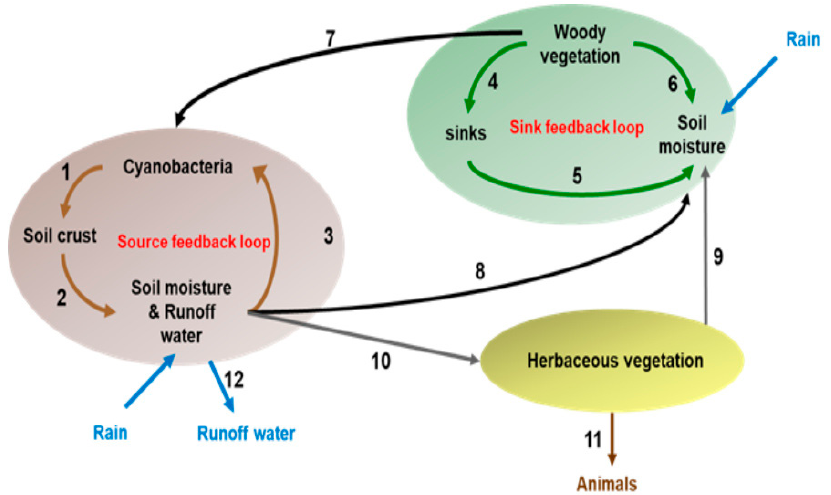
Figure 2. Our model, illustrating the processes and feedbacks of the ecological systems in the Negev. Two positive feedbacks were identified in the Negev system: source feedbacks (Figure 2, processes 1, 2, 3) and sink feedbacks (processes 4, 5, 6). The source feedback loop starts